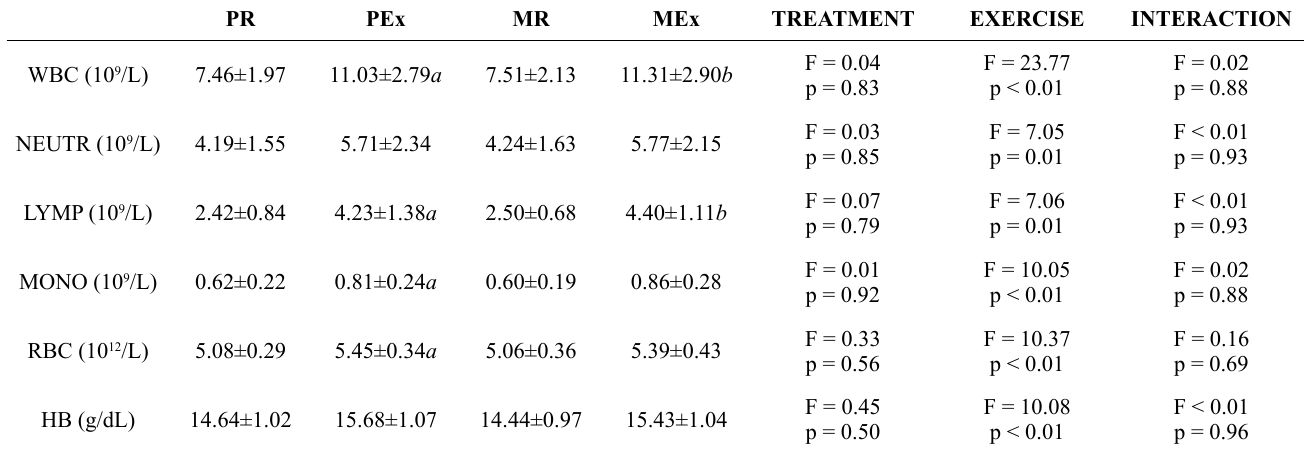
Table I. Results from hematological parameters at rest and after time to exhaustion at maximal aerobic capacity intensity after placebo or melatonin. PR PEx MR MEx TREATMENT EXERCISE